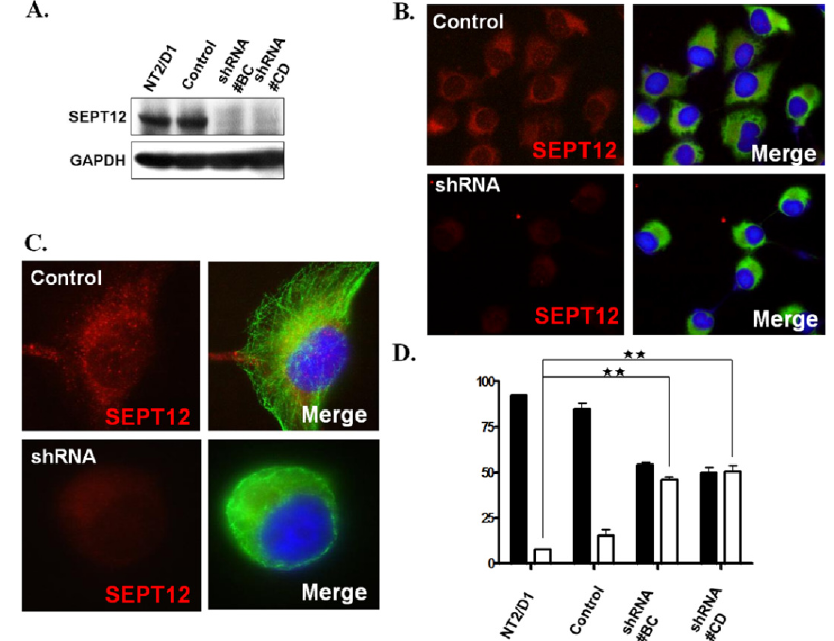
Figure 4. Silencing SEPTIN12 affects α -/ β -tubulins organization in the NTERA-2 d.D1 cell. ( A ) Expression levels of SEPT12 in the stable clone derived from the NTERA-2 d.D1 cell (shRNA #BC and #CD for SEPTIN12 ). Control: a shRNA for the GFP sequence. Each lane was probed with the antibody against SEPT12 or GAPDH (as a loading control) in immuno-blotting; ( B , C ) Immuno-fluorescent detection of SEPT12 (Red) and α -tubulin (Green) in NTERA-2 d.D1 cells treated with shRNA for GFP (control) or SEPTIN12 . Cells were stained with anti-SEPT12 (red, left panel) and merge of images for anti-SEPT12 and anti- α -tubulin (green, left panel). Magnification ×400 ( B ) and ×1000 ( C ); ( D ) Quantification of disorganized α -tubulin in the SEPTIN12 knockdown cell. There are two distinctive patters of α -tubulin in the SEPTIN12 knockdown cell: the polymerized form (black bar) and the disorganized form (white bar). The percentages of two distinct patterns were calculated by randomly selected cells ( n = 300, duplication). Two-tailed Student’s t- test; Error bars indicate ± SEM ( ** , p <